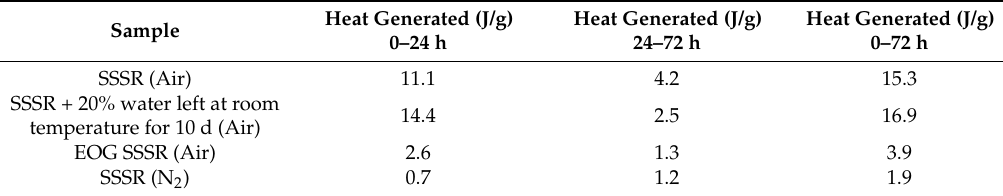
Table 5. Heat generated in fishmeal at 50 °C.